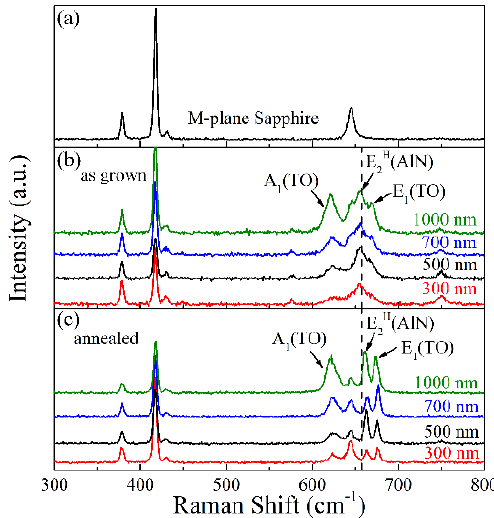
Figure 4. The Raman spectra of ( a ) referenced m -sapphire substrate, ( b ) as-grown, and ( c ) 5 h-annealed AlN samples with different thicknesses.